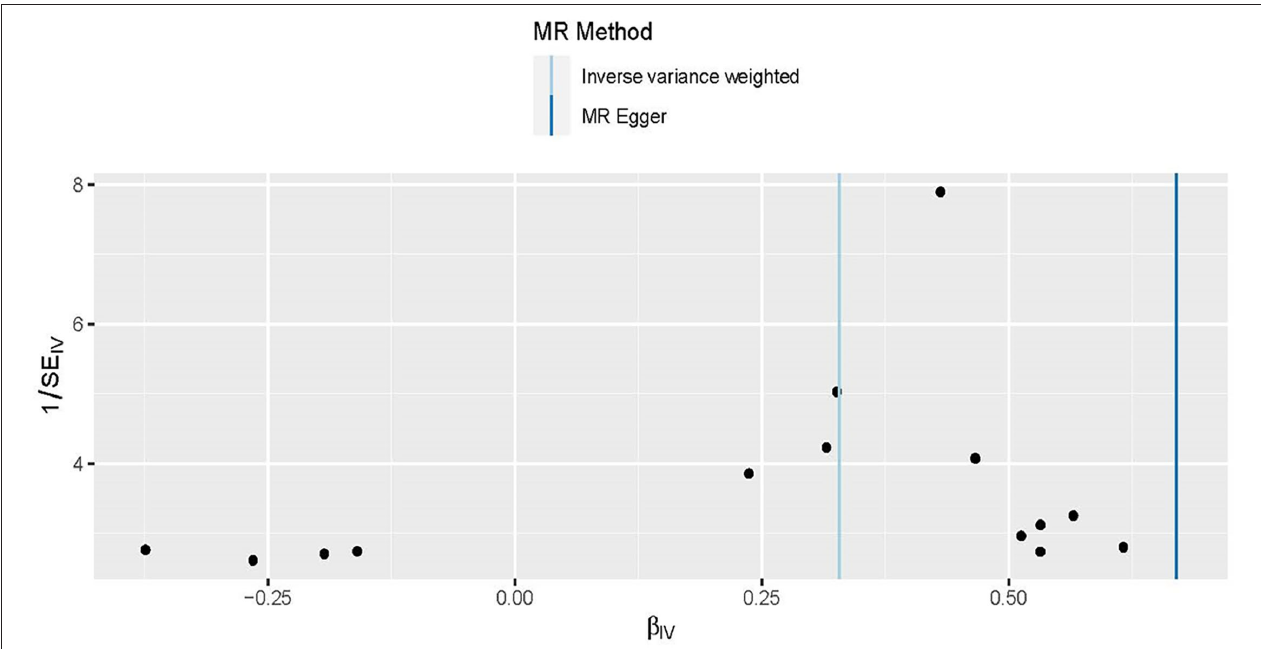
FIGURE 5 | Funnel plots to visualize overall heterogeneity of Mendelian randomization (MR) estimates for the effect of obesity on the risk of HDP. The black point representing an SNP is plotted in relation to the effect size of the SNP on hypertension disorders in pregnancy (x-axis) and reciprocal of the standard errors (y-axis) in the inverse-variance weighted Mendelian randomization. The asymmetry of funnel plots represents directional horizontal pleiotropy, with individual Wald ratios of each SNP that plotted according to its